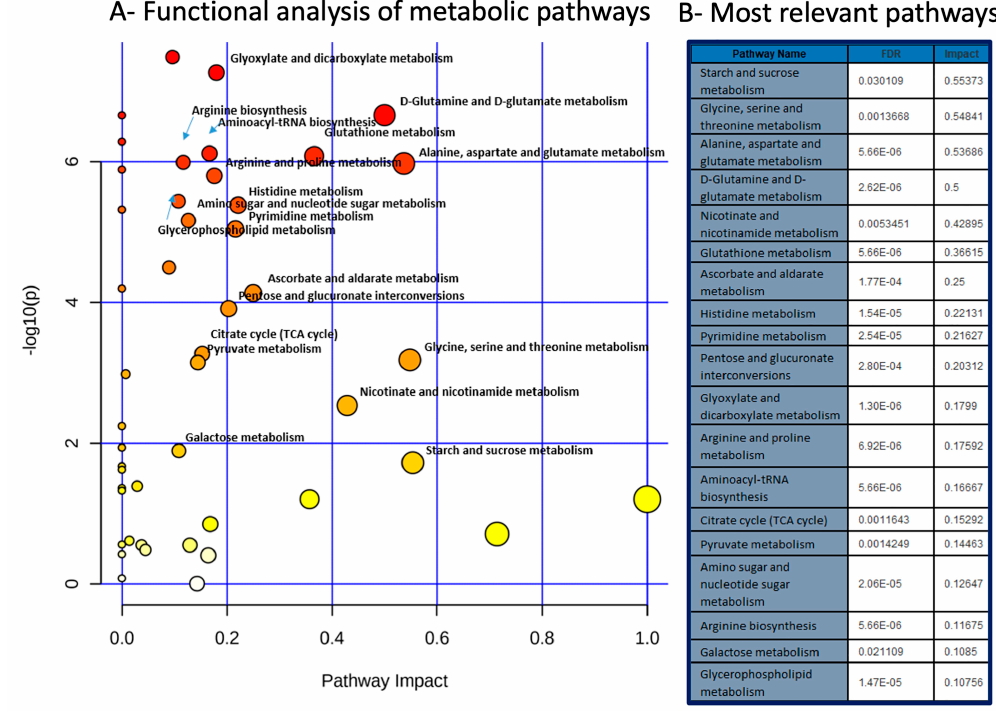
Figure 3. Functional and metabolic pathways analysis in nitrofen-CDH (NCDH) model. ( A ) Metabolome view map of relevant metabolic pathways for changes detected in NCDH compared to vehicle control (VC) based on the pathway enrichment and topology analysis. ( B ) Table of most relevant metabolic pathways with the FDR-corrected p -value (<0.05) and its impact factor (>0.1) from topology